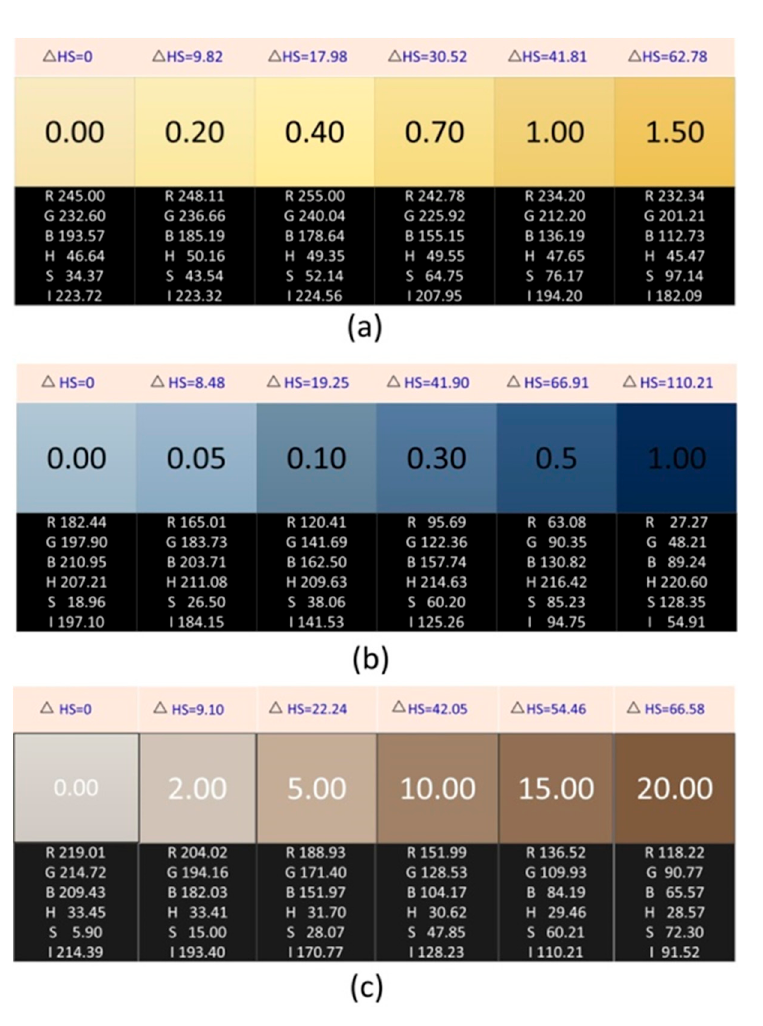
Figure 7. Image information of solutions with different concentrations. ( a ) is the image information of the yellow-brown complex solution. ( b ) is the image information of the blue phosphomolybdenum blue solution. ( c ) is the image information of the brick red complex solution.